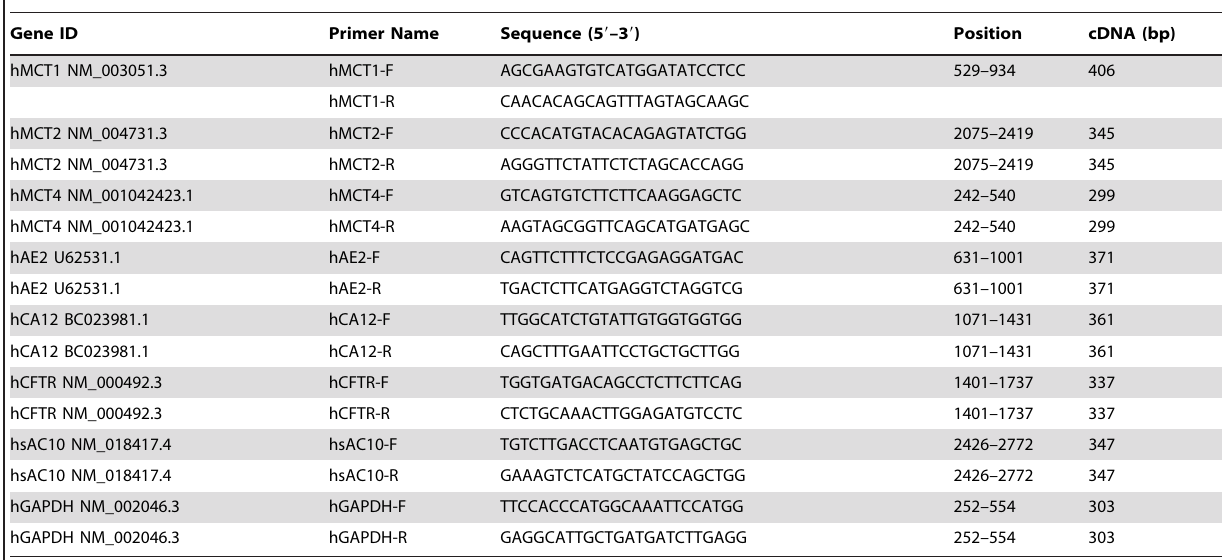
Table 1. Primer Sequences for